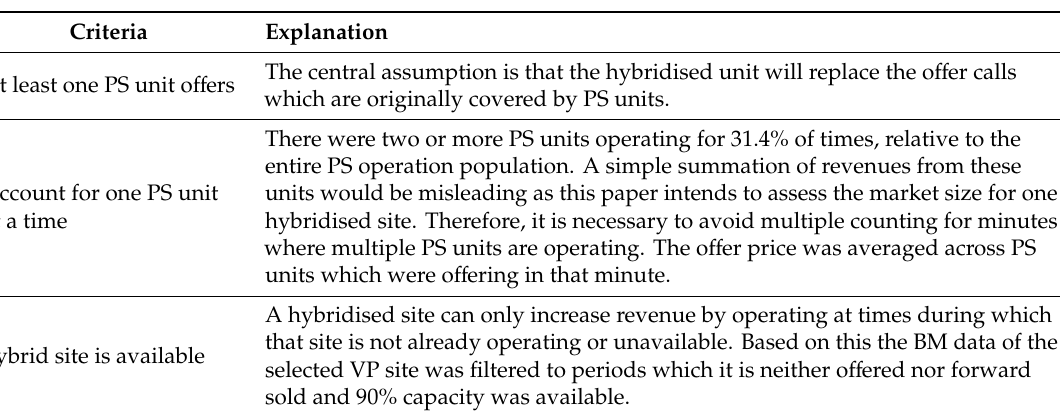
Table 4. Criteria for income